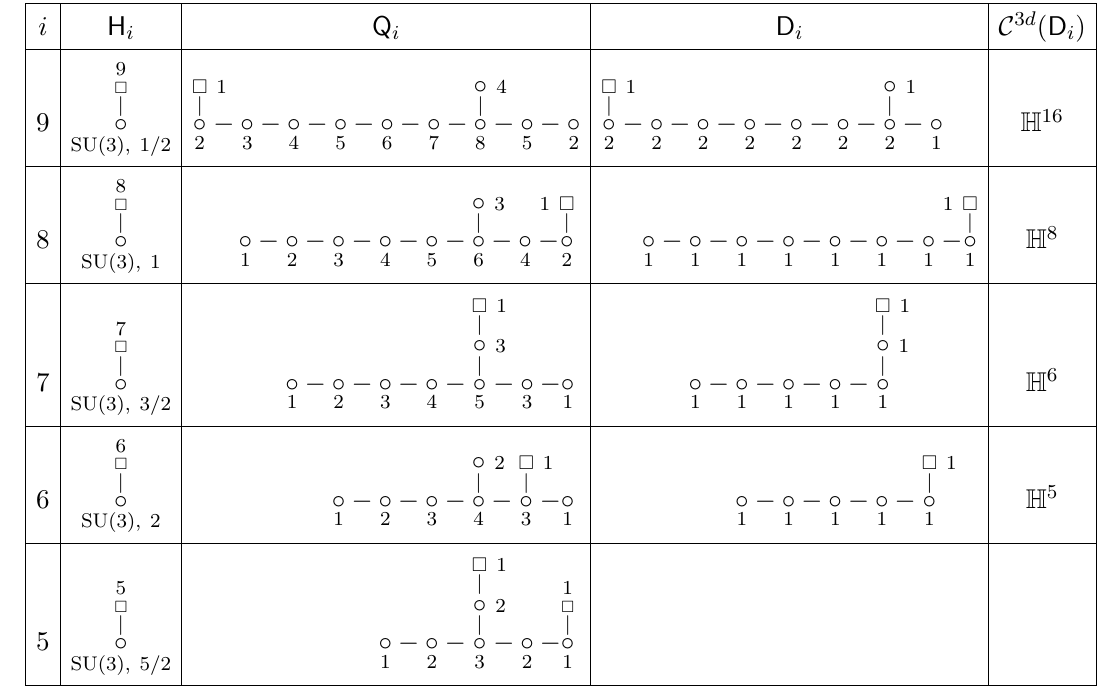
Table 2 . Quiver di(cid:11)erences between Higgs branches of 5 d theories at in(cid:12)nite coupling. H i are 5 d quivers. Q i are 3 d quivers such that H 1 ( H i ) = C 3 d ( Q i ) [41]. On the right, the quiver subtractions have been computed D i = Q i (cid:0) Q i (cid:0) 1 .